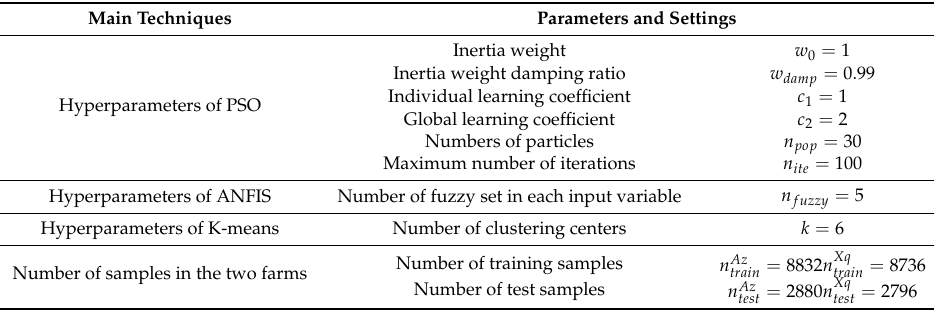
Table 3. Main setting parameters for